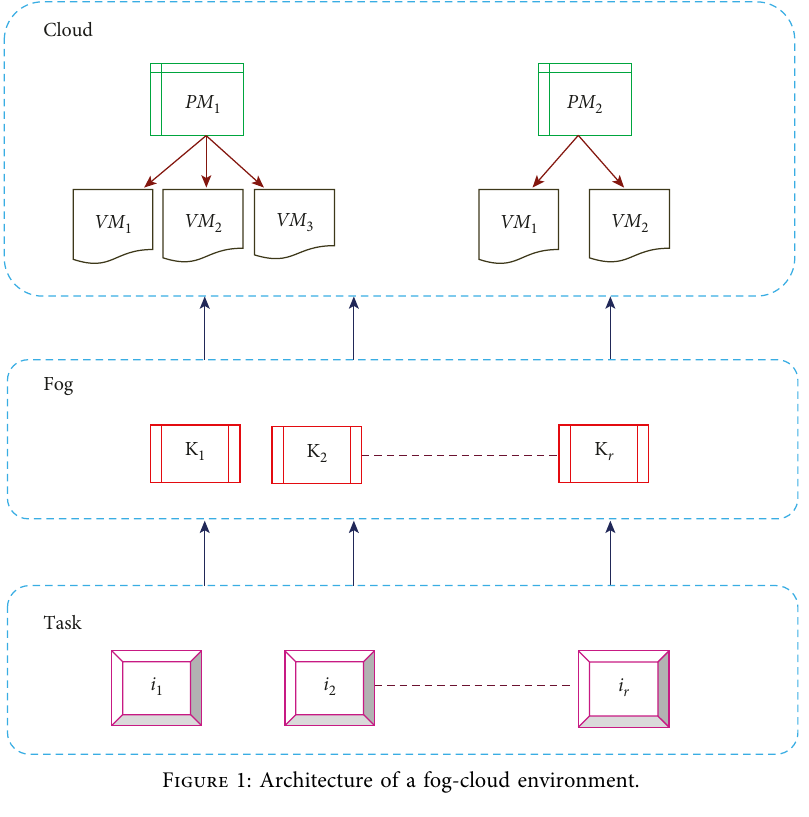
Figure 1: Architecture of a fog-cloud environment.